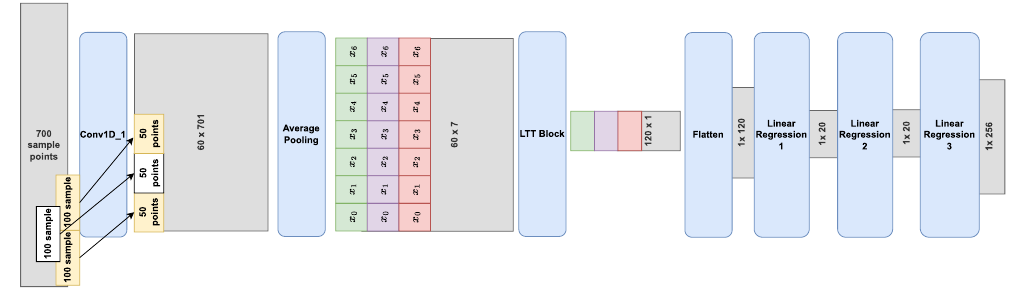
Figure 20: Inner working of TT-DCNN for ASCADv1_f